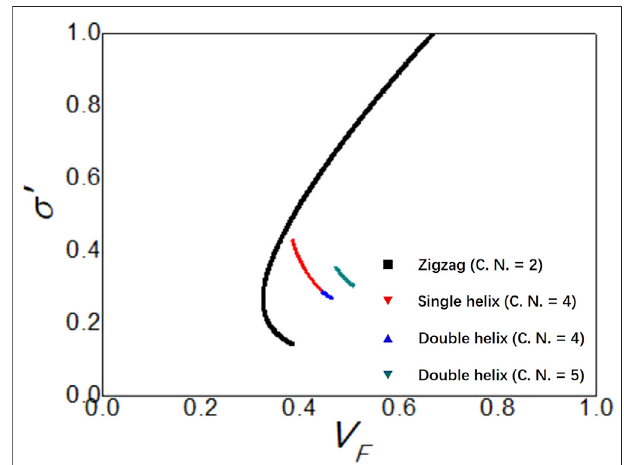
FIGURE 7 | Plot of the rescaled electrical conductivity σ ′ as a function of the volume fraction V F of spheres. For each type of helical structures, σ ′ decreases monotonously for increasing V F . For the zigzag structures at (cid:1)(cid:1) √ D ∈ ( 1 , 1 + 3 /2 ) ,thisisonlythecaseforalimitedregimeof σ ′ ,where σ ′ increases monotonously with V F for all other values of σ ′